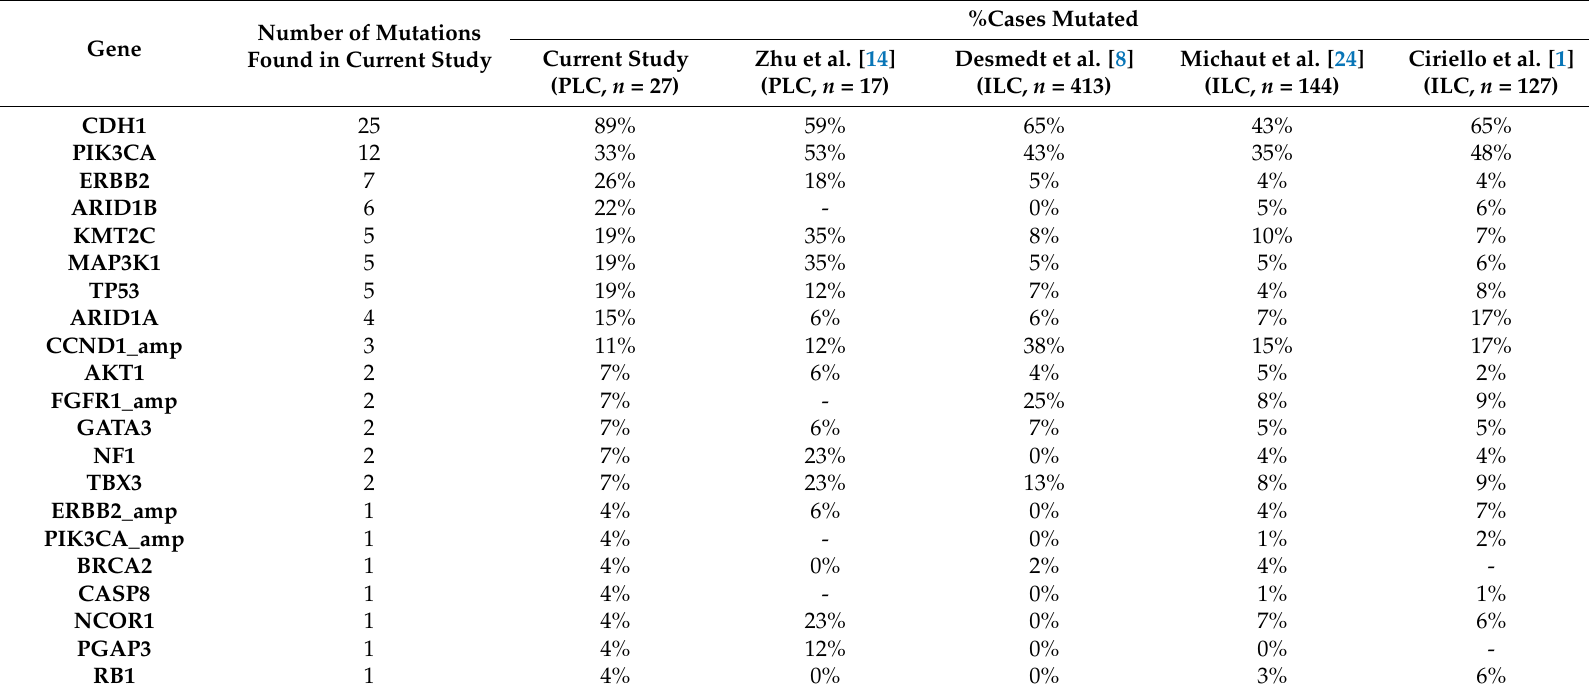
Table 2. Comparative results with published data for gene mutation